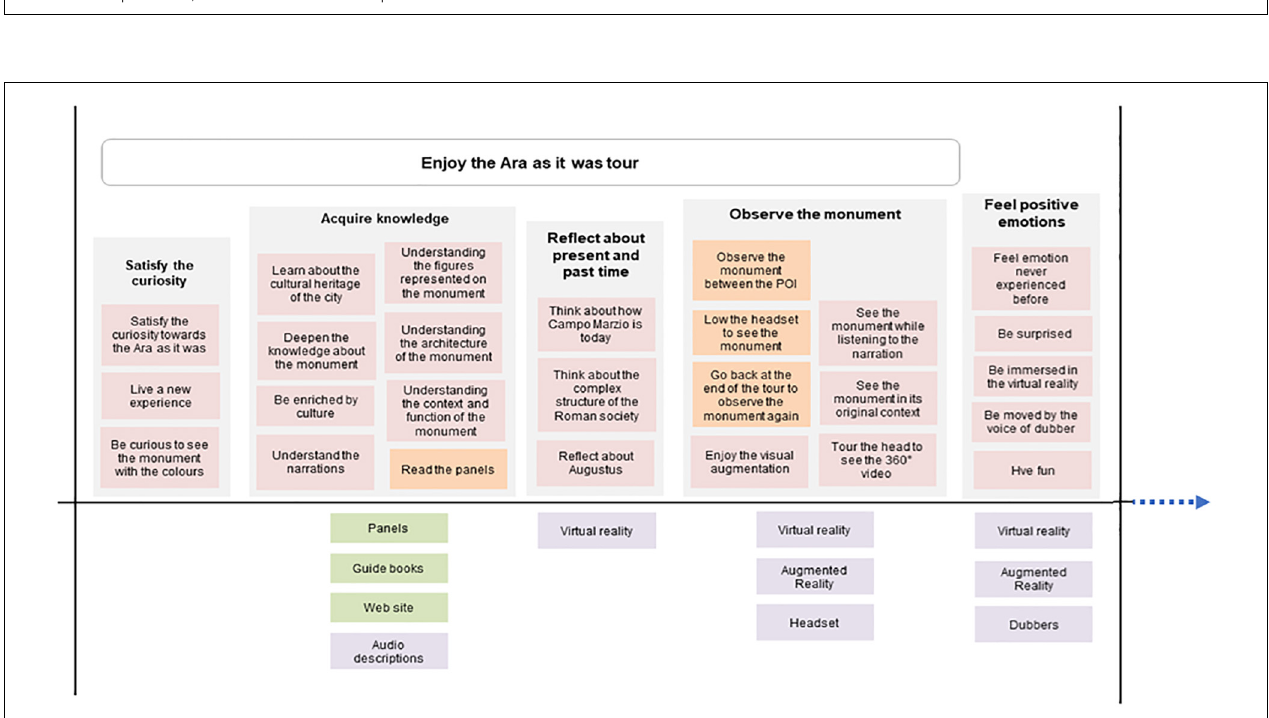
FIGURE 1 | First portion of the Activity Diagram representing: in the upper part, the preparatory activities in the pre- phase of the visit (learn about the museum, organize the visit, reach the museum, and get the ticket); in the bottom part, the existing services/tools/information provided by both the Ara Pacis Museum and other service providers, that the visitors used to perform the above activities.